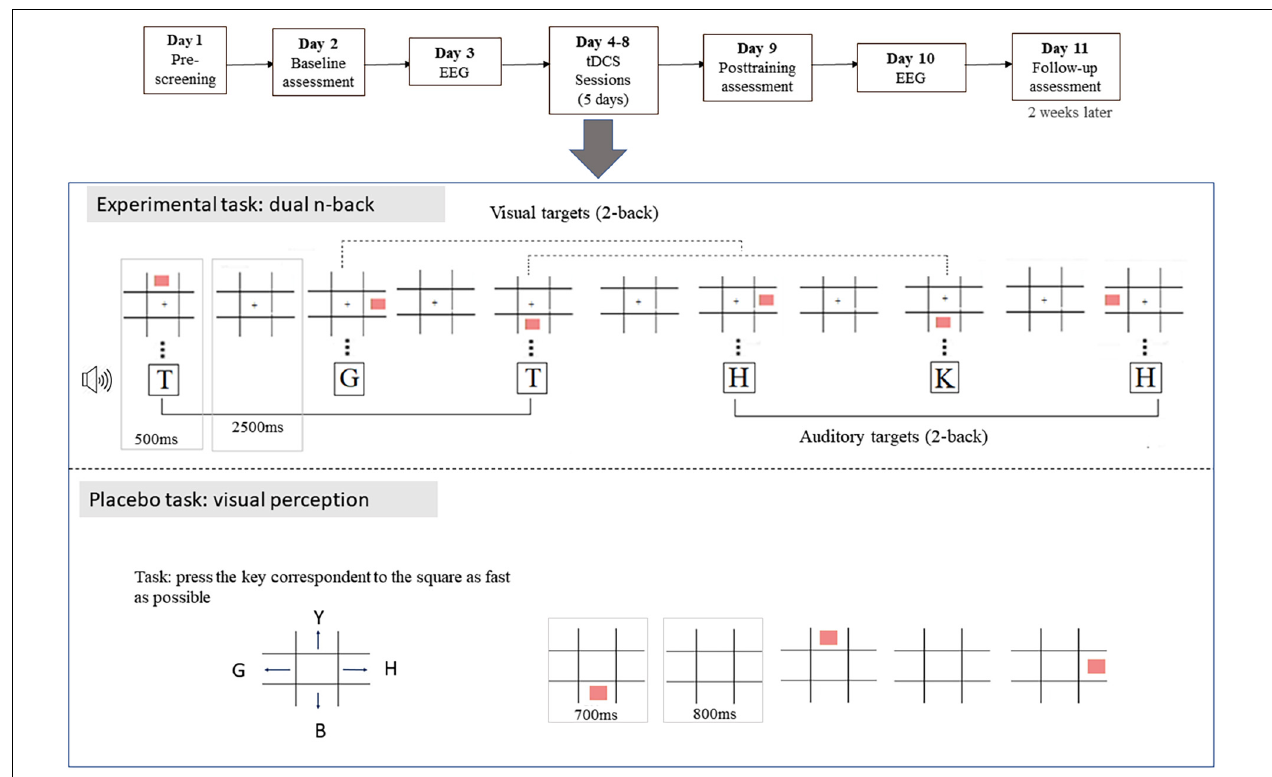
FIGURE 1 | Schematic representation of the sessions. The experimental task was illustrated for a 2-back condition. All participants underwent 11 sessions, as represented in the top of this figure. Participants from atDCS+WMT and stDCS+WMT groups performed the dual n -back task while participants from the double-sham group performed the visual perception